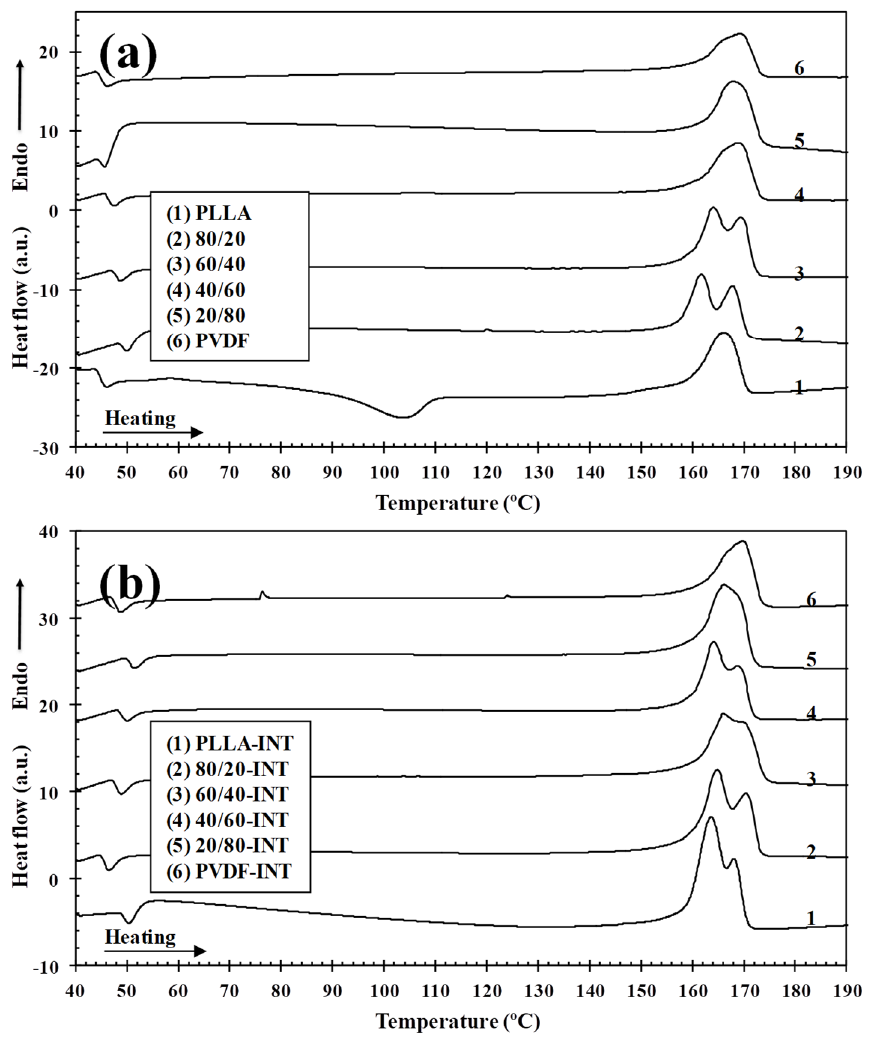
Figure 9. DSC thermograms of melting of ( a ) binary PLLA/PVDF and ( b ) ternary PLLA/PVDF/INT- WS 2 hybrid nanocomposites obtained during heating at 10 °C/min after cooling from the melt to room temperature at 10 °C/min.